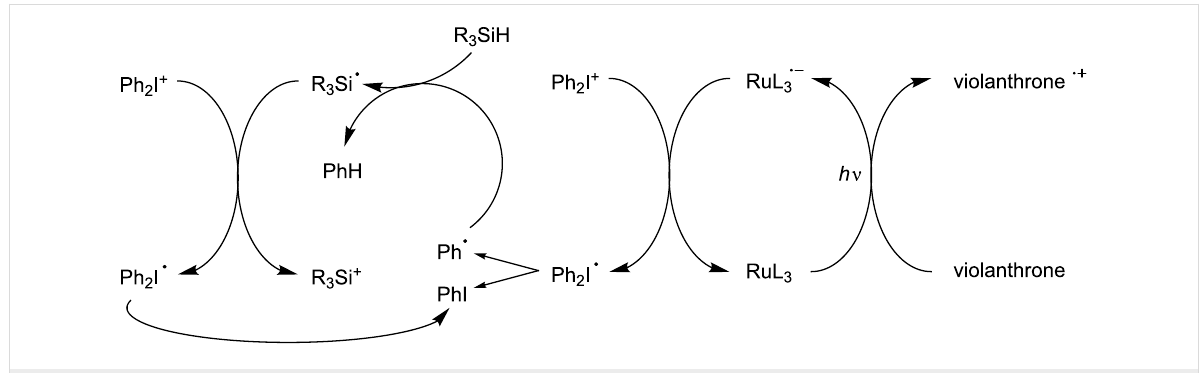
Scheme 13: Reaction mechanisms for the Violanthrone/Ru(ligand) 32+ /Ph 2 I + /R 3 SiH system upon visible